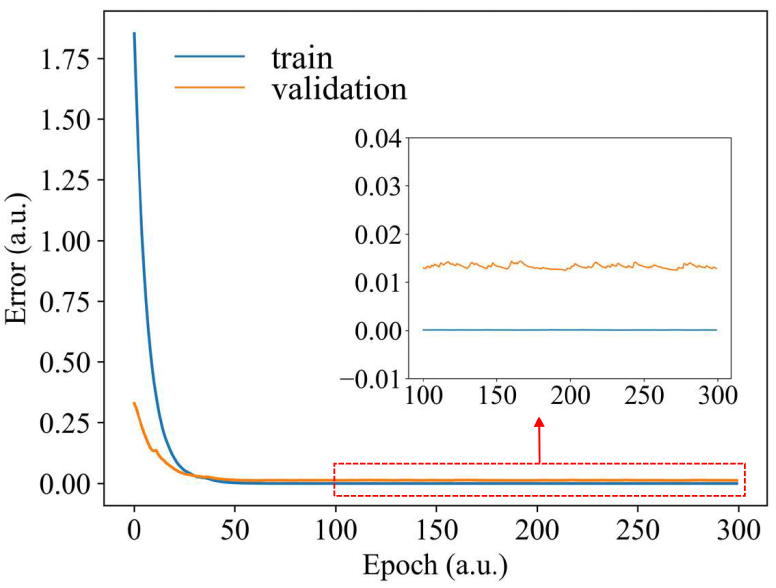
Figure 6. The error of WTBMobileNet with the epochs